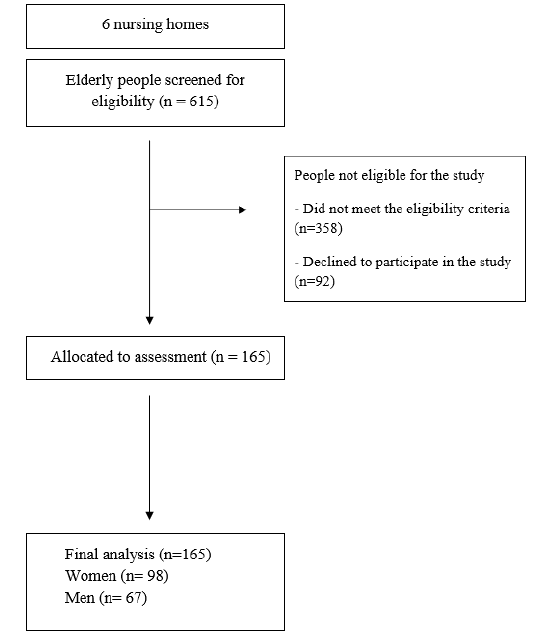
Figure 1. Flow diagram of participants through the study.